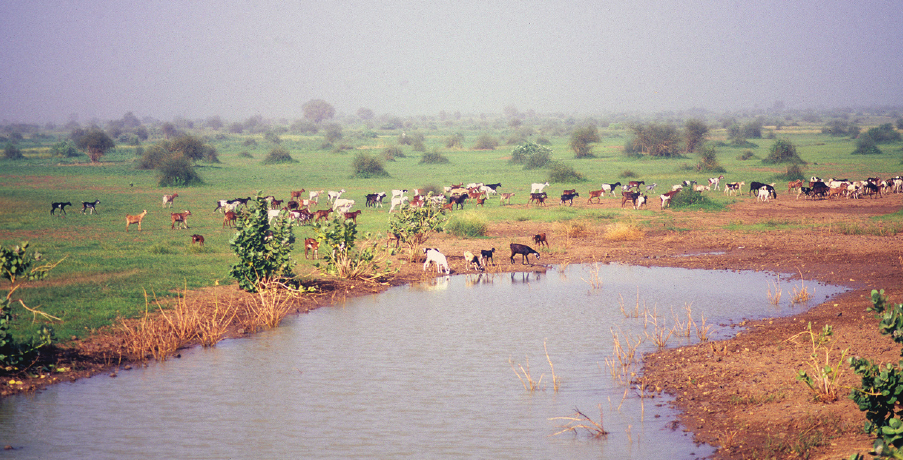
Figure 3. Temporal pond where Ptychadena schillukorum was found in Aleg, Mauritania (photo Rafael